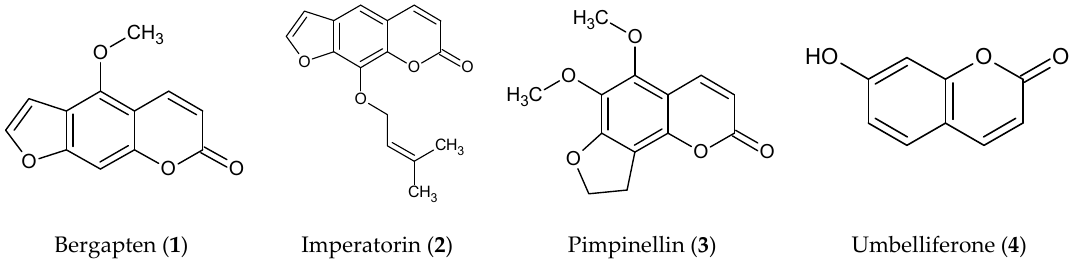
Figure 1. Chemical structures of compounds 1–4.